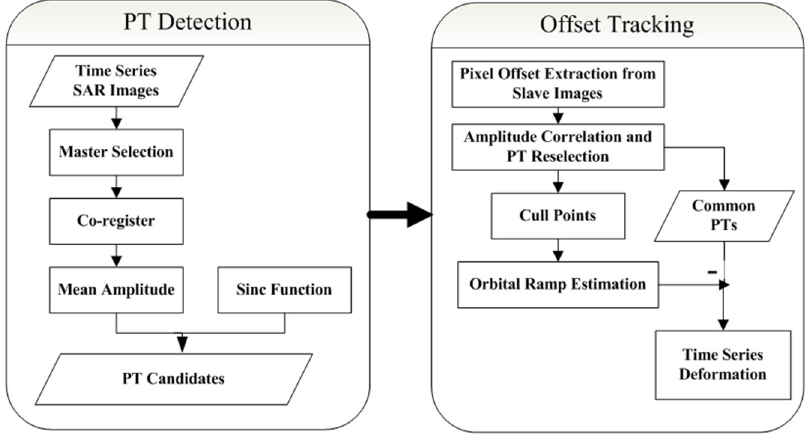
Figure 1. The process flow of PT offset tracking.